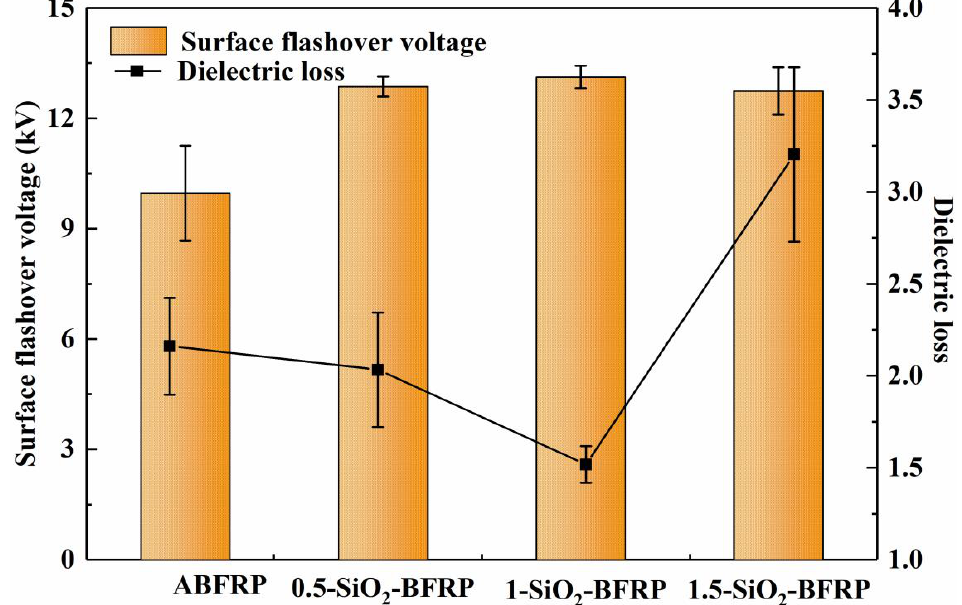
Figure 7. Dielectric loss and surface flashover voltage of composites treated with different mass fraction of SiO 2 -COOH.